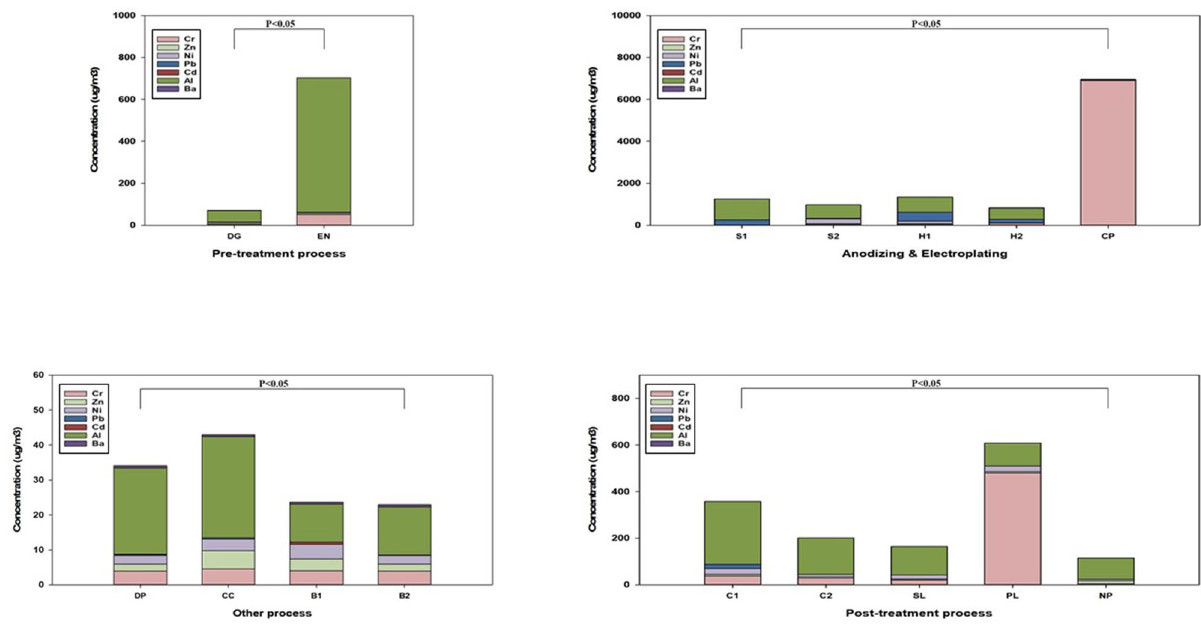
Figure 3. Heavy metals ratio in all the processes. The heavy metals concentrations are arithmetic means. There are a total of seven heavy metals. Cr Chromium, Zn Zinc, Ni Nickel, Pb Lead, Cd Cadmium, Al Aluminum, Ba Barium, DG Degreasing, EN Etching & Neutralization, S1 Soft Anodizing_1, S2 Soft Anodizing_2, H1 Hard Anodizing_1, H2 Hard Anodizing_2, CP Chromium plating, C1 Coloring_1, C2 Coloring_2, SL Sealing, PL Polishing, NP Non polishing, DP Drying & Packaging, CC Chromium cleaning, B1 Blank (Plating & Anodizing), B2 Blank (Drying &